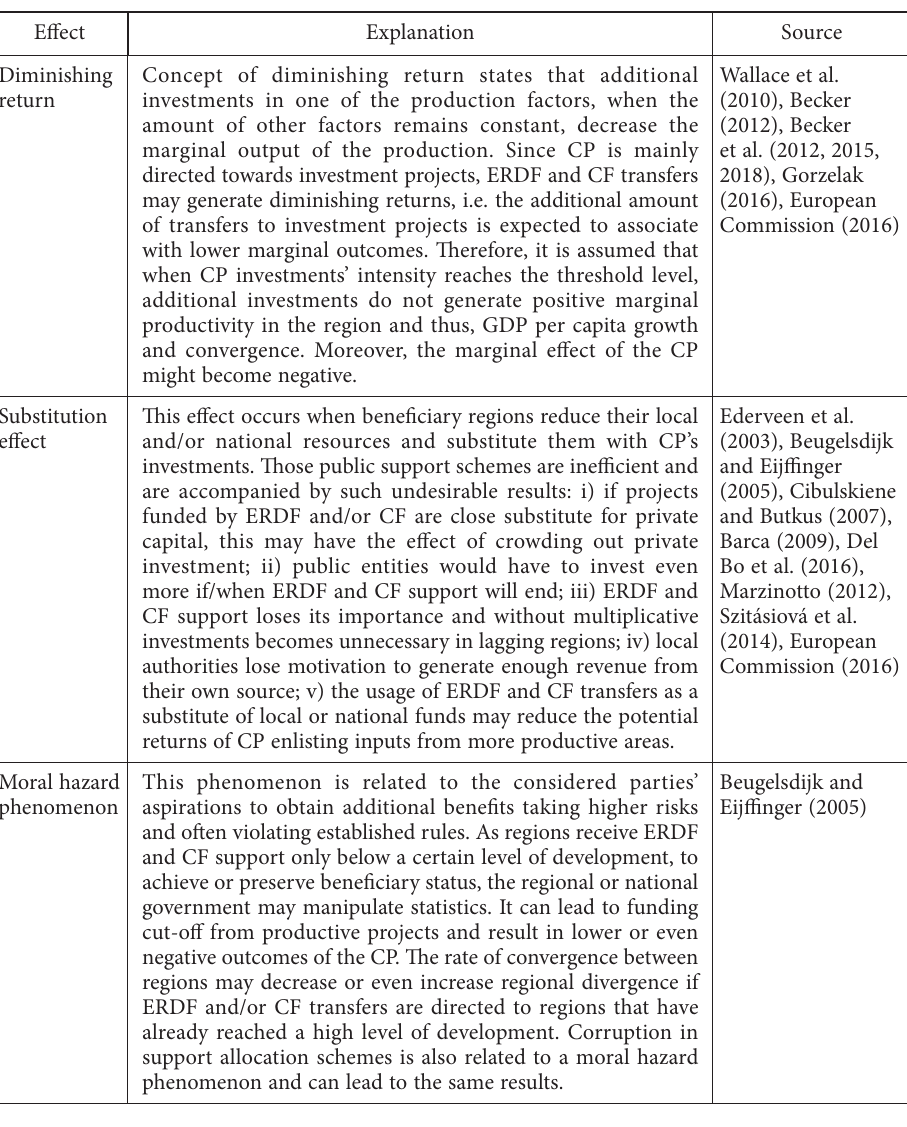
Table 1. Justification of non-linear relationship between CP and its outcomes (source: author’s construc- tion based on analysed